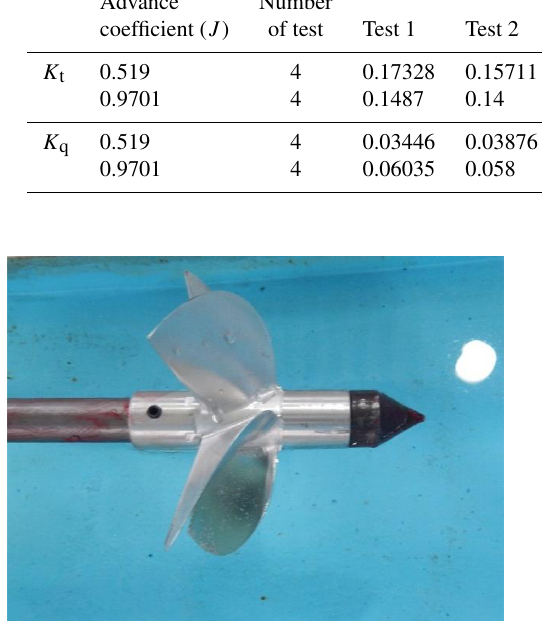
Figure 5. Front view of a five-blade surface-piercing propeller.